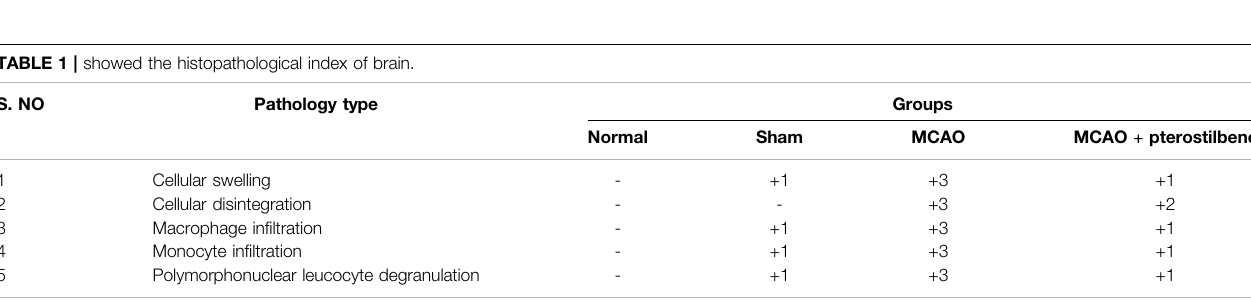
TABLE 1 | showed the histopathological index of